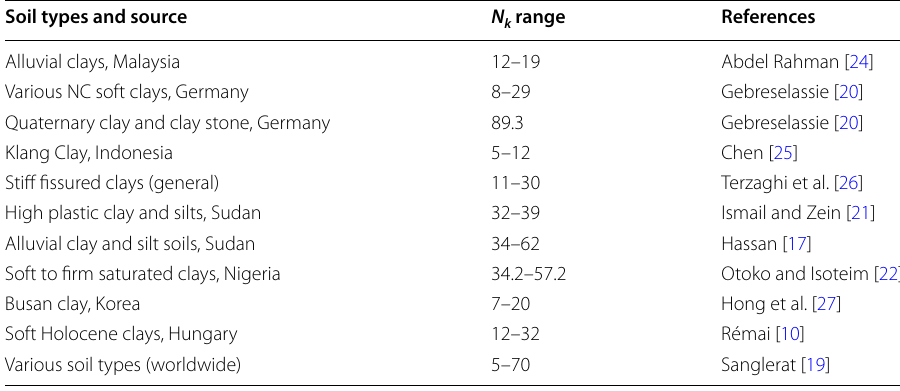
for various soil types k